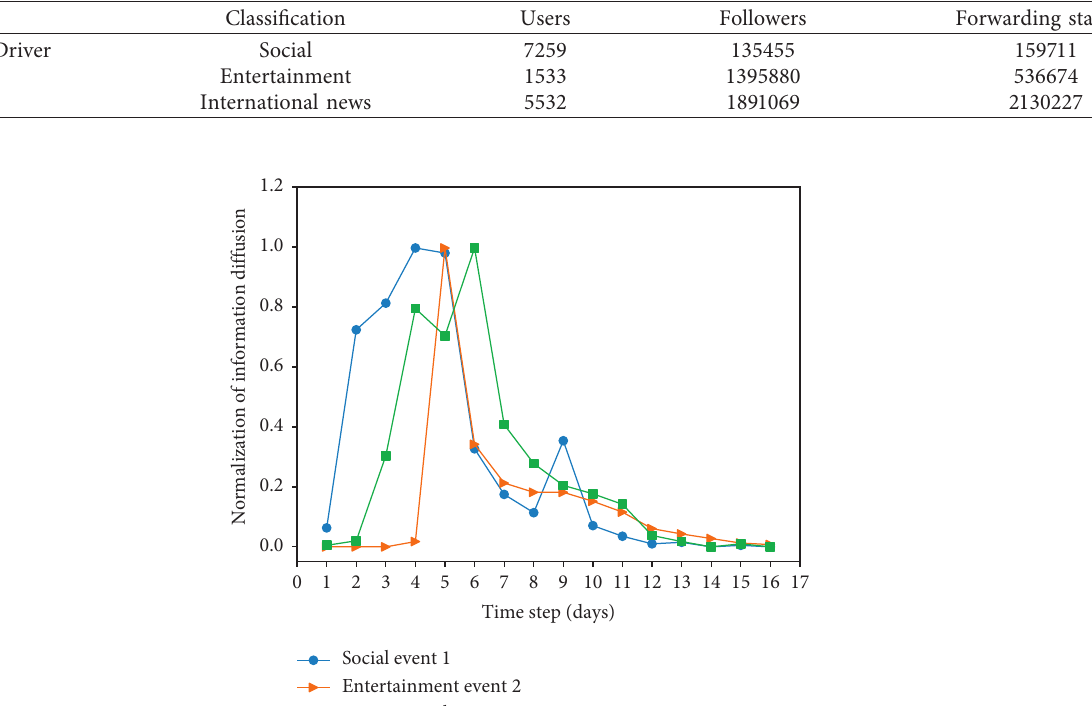
Table 1: Details about the three datasets of hot public opinion